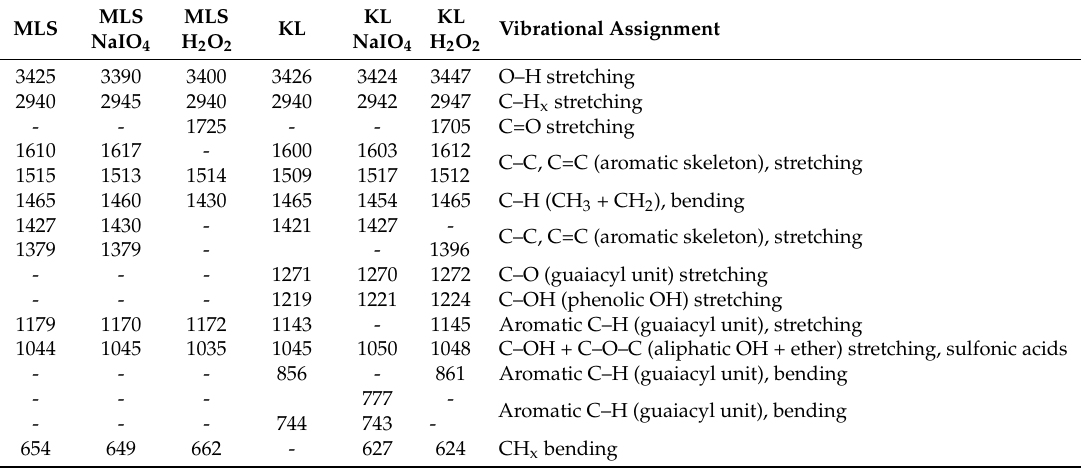
Table 1. Vibrational wavenumbers (cm − 1 ) attributed to magnesium lignosulfonate (MLS), kraft lignin (KL), and biopolymers activated using NaIO 4 and H 2 O 2 .